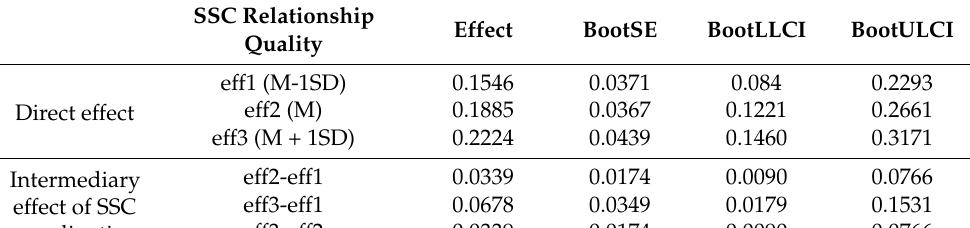
Table 10. Direct and intermediary effects of supply chain relationship quality at different levels.